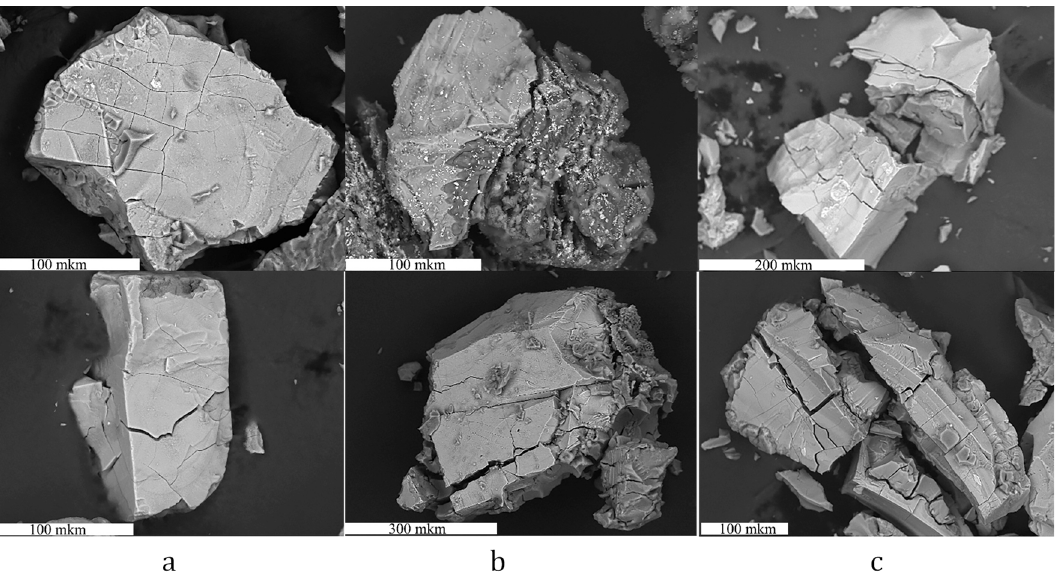
Figure 1. Different types of eudialyte grains transformation at tangential (layer-by-layer) dissolution in HNO 3 ( a ) at the normal and tangential dissolution in H 2 SO 4 ( b ) due to the normal mechanism of dissolution in HCl ( c ).